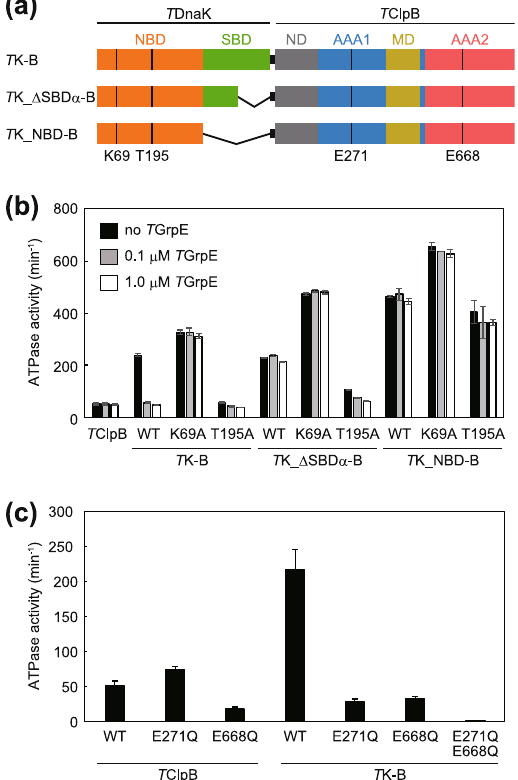
Figure 2. ATPase activities of fusion proteins. ( a ) Schematic drawing of the construction of T K-B, T K_ Δ SBD α -B, and T K_NBD-B are shown. ( b ) ATPase activities of T K-B, T K_ Δ SBD α -B, T K_NBD-B and their mutants carrying K69A and T195A mutations in the T DnaK portion. ATPase activities in the absence (black bar) or presence of T GrpE (0.1 μ M; gray bar, 1.0 μ M; open bar) are shown. ( c ) ATPase activities of T ClpB and T K-B and their mutants carrying E271Q and/or E668Q mutations in the T ClpB portion are shown. ( b , c ) The measurements were performed at 55 °C in the presence of 3 mM ATP by using an ATP regeneration system. Error bars represent standard deviations of three or more independent measurements. WT,